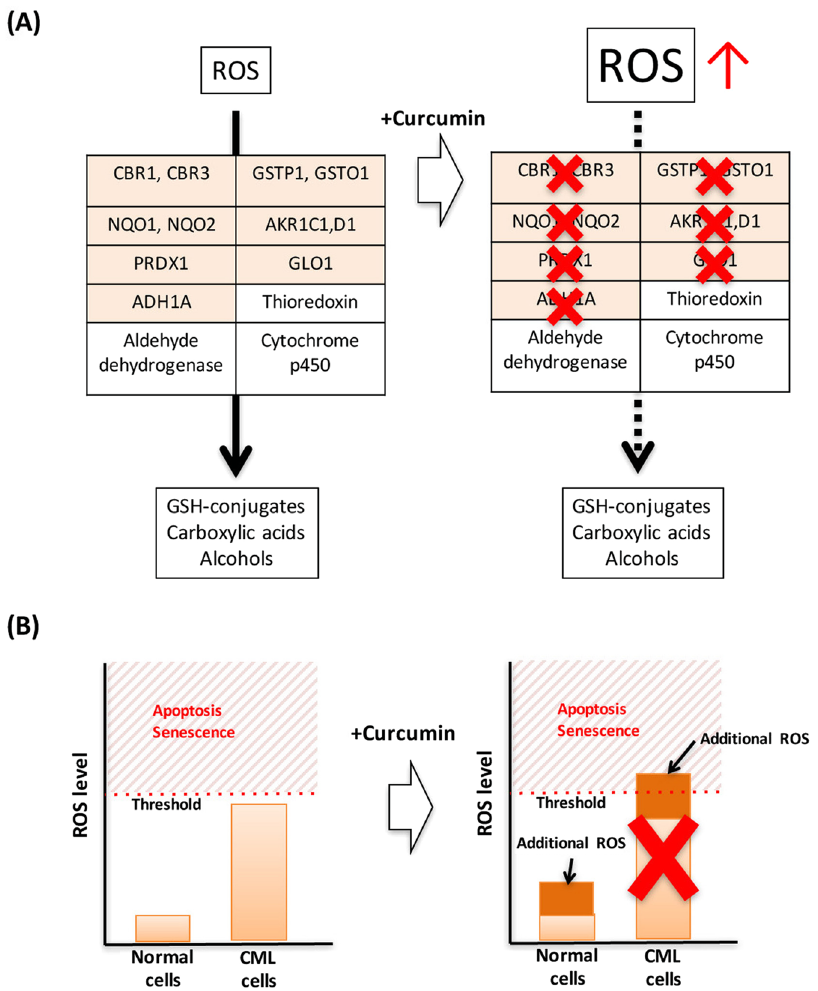
Figure 8. Model of the curcumin-mediated regulation of intracellular ROS ( A ) and cell viability in CML cells ( B